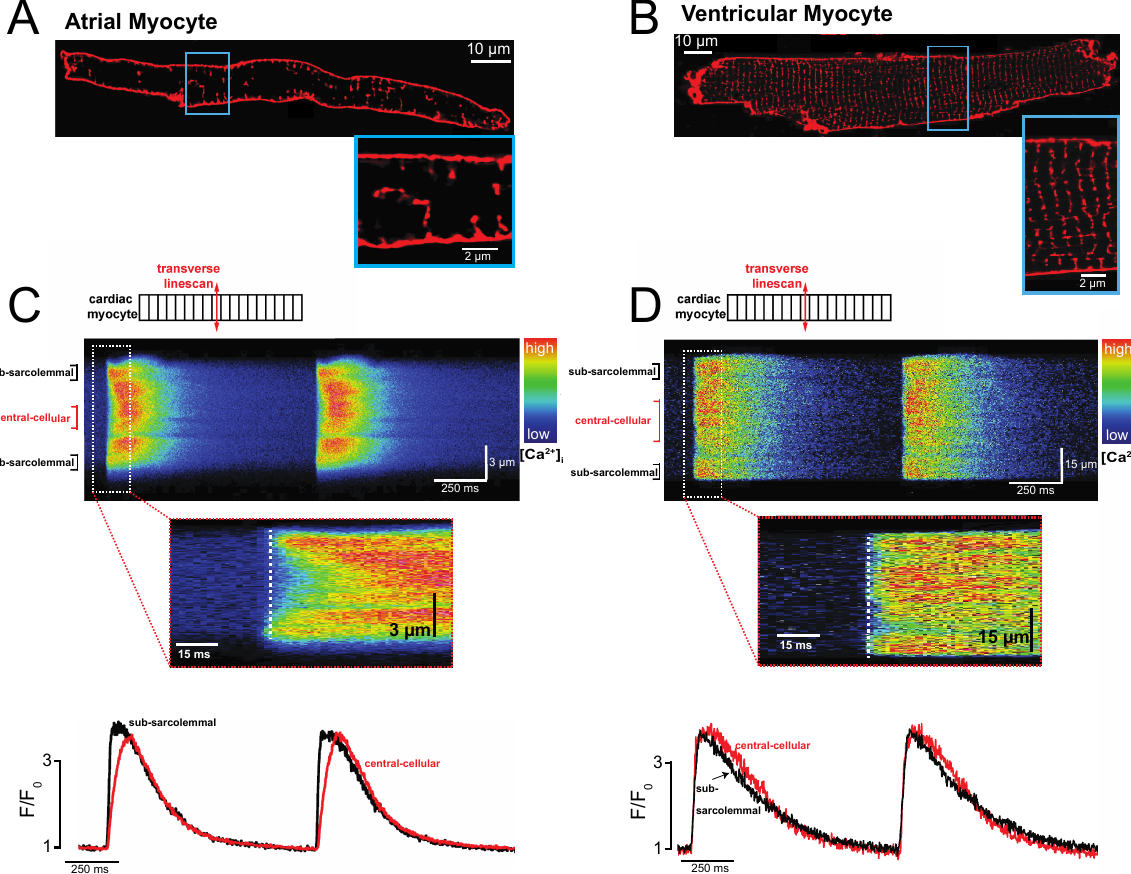
Figure 1. Spatiotemporal Ca 2+ release in atrial and ventricular cardiac myocytes. ( A ) Transverse tubules. Confocal laser scanning image of a freshly isolated living atrial myocyte stained with the membrane dye Di-8-ANEPPS. ( B ) The same as in ( A ), but in a freshly isolated living ventricular myocyte. ( C ) Intracellular Ca 2+ release. Shown is an atrial myocyte loaded with the fluorescent Ca 2+ indicator Fluo-4. A transverse confocal linescan is used to track the spatio-temporal intracellular Ca 2+ release from the subsarcolemmal domain to the center of the cell in an atrial myocyte during external field stimulation. The inset shows the onset of Ca 2+ release at the outer cell membrane in the subsarcolemmal space compared to the central cellular domain. Below are the domain-specific Ca 2+ transients derived from the confocal images shown in the upper panel. ( D ) The same as in ( C ) but for a ventricular myocyte.